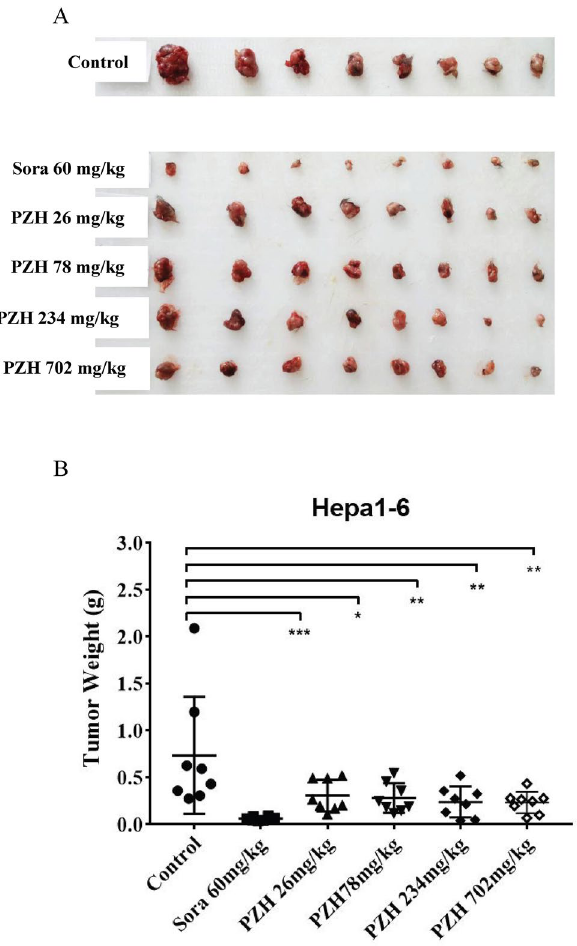
Figure 1. Inhibition of Pien Tze Huang (PZH) on xenograft tumor growth in vivo. C57BL/6J mice were inoculated with 5.0 × 10 6 Hepa1-6 cells, PZH (26–702 mg/kg/day), sora (60 mg/kg/day), and 0.5% CMC as control were supplied one time per day for 21 consecutive oral administrations the next day after inoculation, then the tumor xenografts were excised completely from tissues. ( A ) A macroscopic view of the xenografted tumors after drugs’ treatments. ( B ) Analysis of tumor weight inhibition rate, n = 8, mean ± SD, one-way ANOVA, * p < 0.05 versus control group, ** p < 0.01 versus control group, *** p < 0.001 versus control